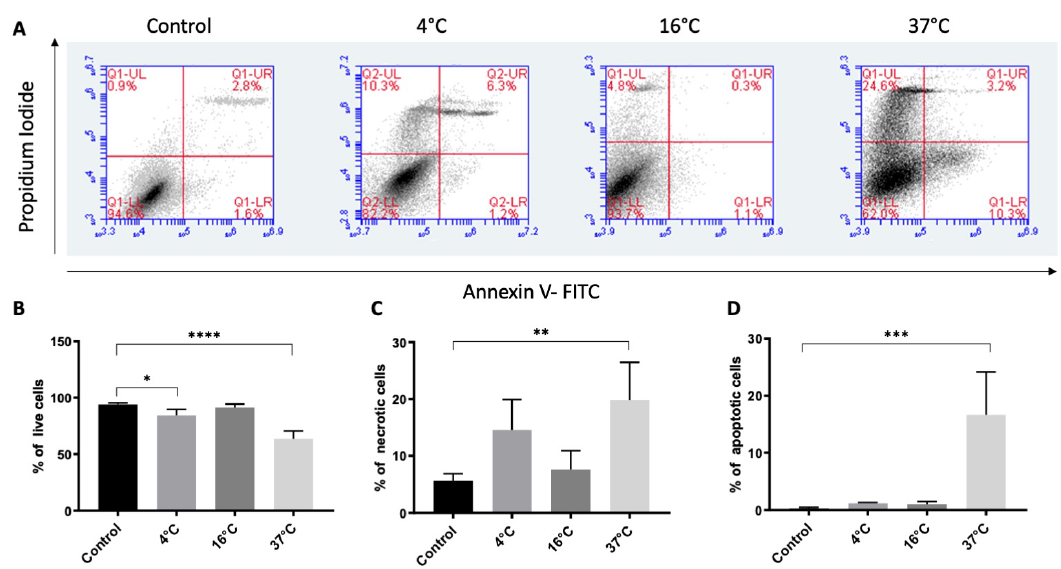
Figure 3. E ff ect of storage temperature on the viability of ARPE19 cells. Live, necrotic and apoptotic cells were detected by flow cytometry using annexin V and propidium iodide (PI). Cultured ARPE-19 cells were stored at three temperatures for three weeks. Dot plots ( A ) from the flow cytometry analysis were gated based on unstained cells for each experiment (not shown). The cell populations were distributed in four quadrants where the lower left quadrant represents live cells (annexin V and PI-negative), the upper left and right quadrants together represent necrotic cells (only PI-positive as well as both annexin V and PI-positive), while the lower right quadrant represents apoptotic cells (annexin V-positive and PI-negative). Control cells were not stored. The bar chart illustrates the percentages of live ( B ), necrotic ( C ), and apoptotic ( D ) cells. Data are presented as the mean ± standard deviation of the mean of four independent experiments. * p < 0.05, ** p < 0.01, *** p < 0.001, and **** p < 0.0001. Cell viability after three weeks of storage (defined as the percentage of cells that were